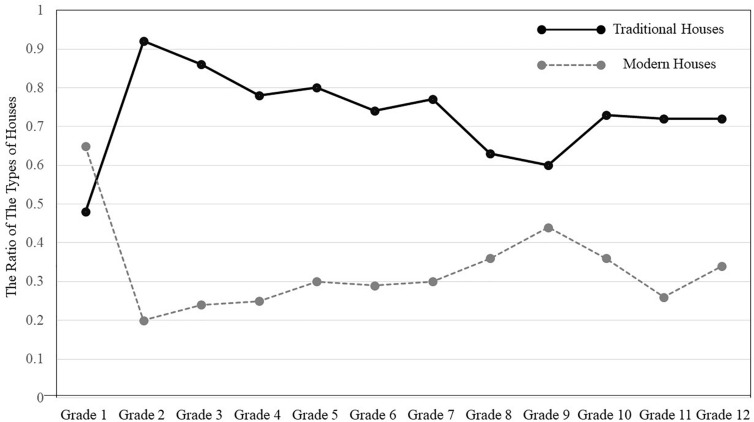
The ratio of traditional vs. modern houses.